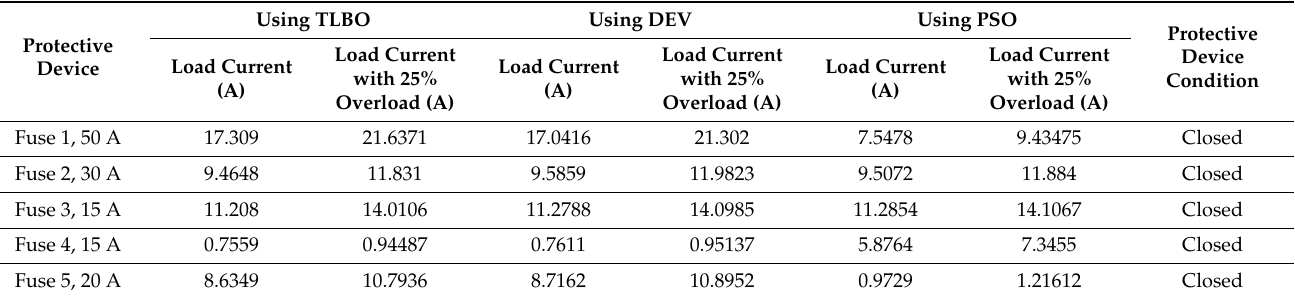
Table 5. Protective device conditions for restored network considering protection constraints.